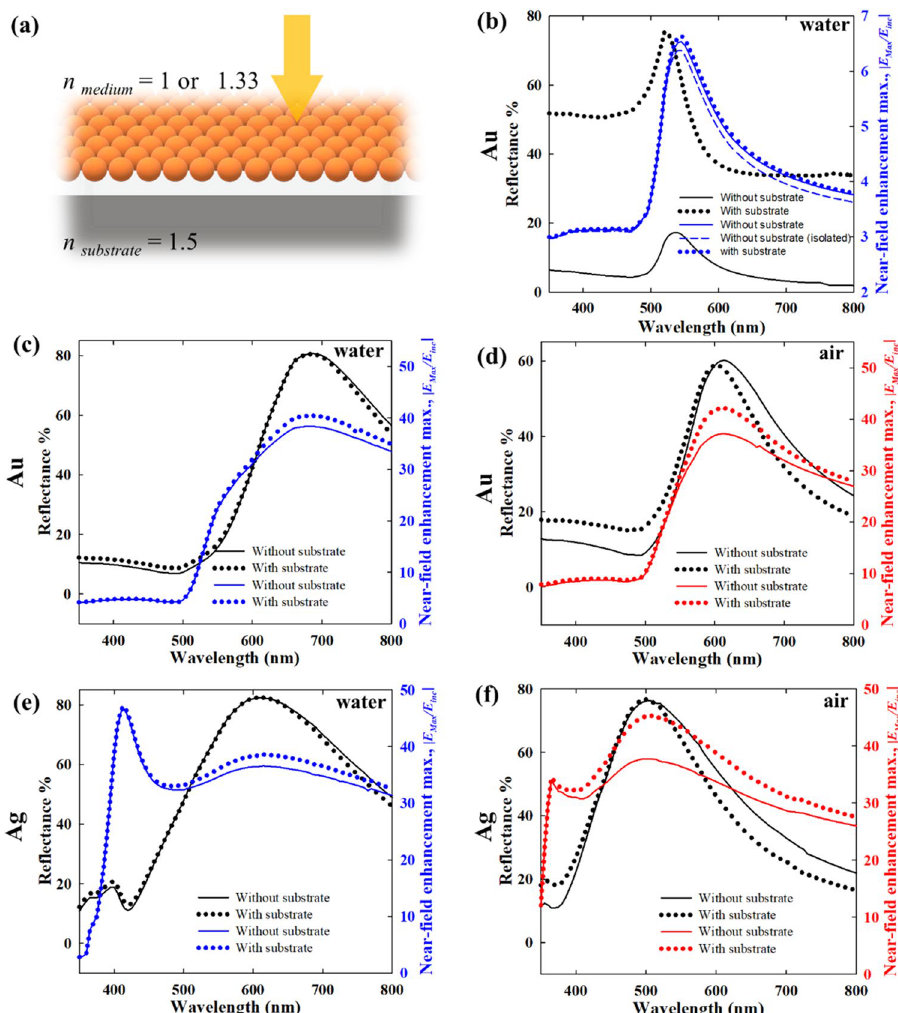
Figure 10. ( a ) Schematic of nanoparticles on substrate with normal direct incidence i.e. θ = 0°. ( b ) Effect of substrate ( n sub = 1.5, n medium = 1.33) on reflectance and near-field enhancement maximum spectra for Au nanoparticle assembly with large interparticle distance, 64 nm. Effect of substrate for ( c ) n medium = 1.33 and ( d ) n medium = 1 with close packed Au nanoparticle assembly i.e. interparticle distance 1 nm, comparing reflectance and near-field enhancement maximum spectra. Effect of substrate for ( e ) n medium = 1.33 and ( f ) n medium = 1 with close packed Ag nanoparticle assembly i.e. interparticle distance 1 nm, comparing reflectance and near-field enhancement maximum